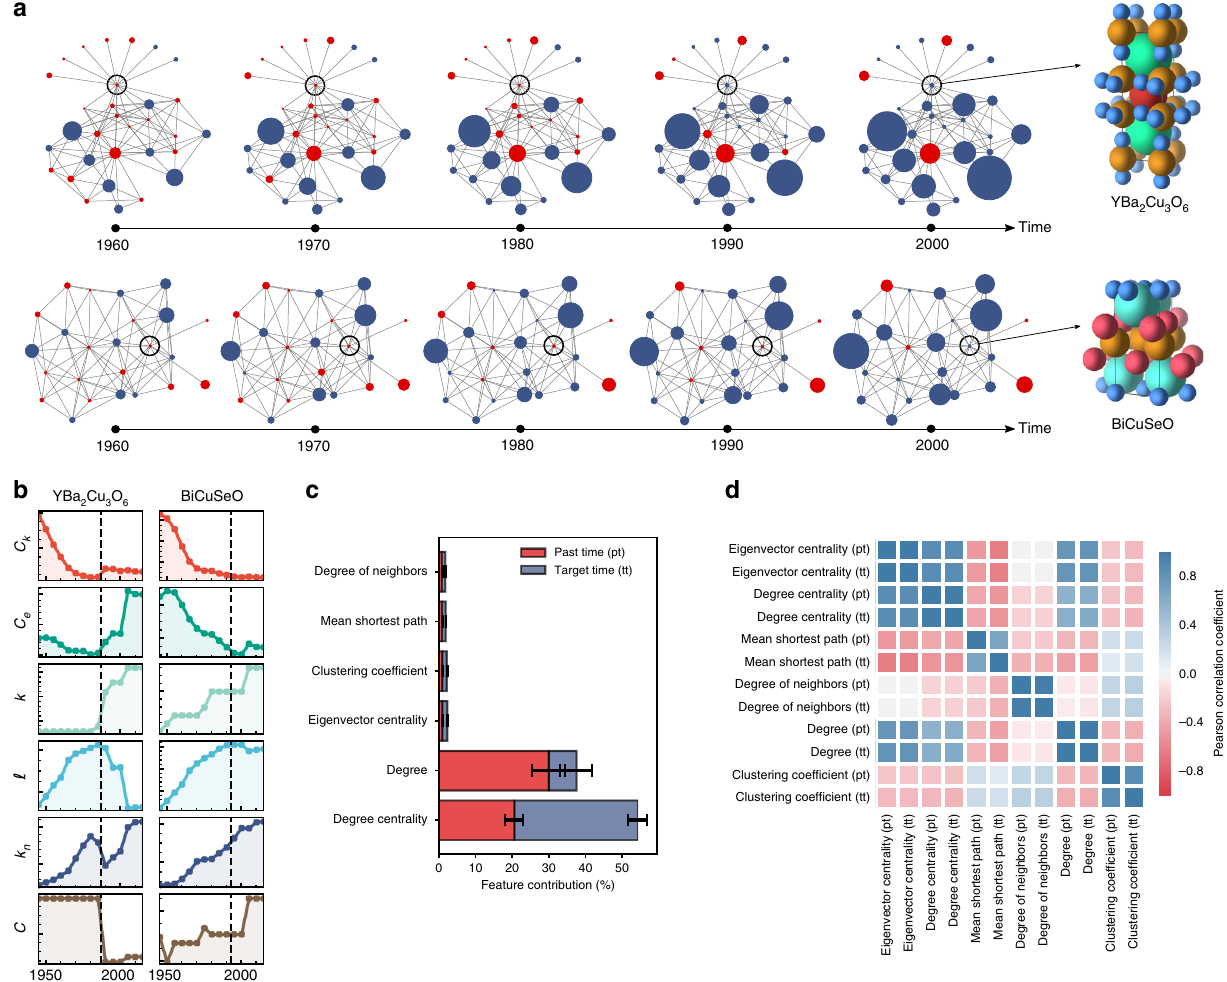
Fig. 4 Network evolution and properties of the machine-learned synthesizability models. a Time evolution of the local environments of two sample materials (marked with open circles), superconductor YBa 2 Cu 3 O 6 , and thermoelectric BiCuSeO, in the materials stability network. Materials (nodes) discovered by a given temporal state of the network are shown in blue, whereas those awaiting discovery are red. Node size is proportional to degree. b Time evolution of the network properties of sample materials YBa 2 Cu 3 O 6 and BiCuSeO, namely, degree and eigenvector centralities ( C k and C e ), degree ( k ), mean-shortest-path ð ‘ Þ , mean degree of neighbors ( k n ), and clustering coef fi cient ( C ), where the vertical dashed lines show the approximate time of discovery. c Feature contributions to the RF model as derived from the Gini importance. d Pearson correlation coef fi cients of time-dependent network properties used in models as features, where pt and tt denote past time and target time, respectively, corresponding to a given sequence of window size of two (see “ Methods ” ). Variables and names of network properties are used interchangeably in ( b ), ( c ), and ( d